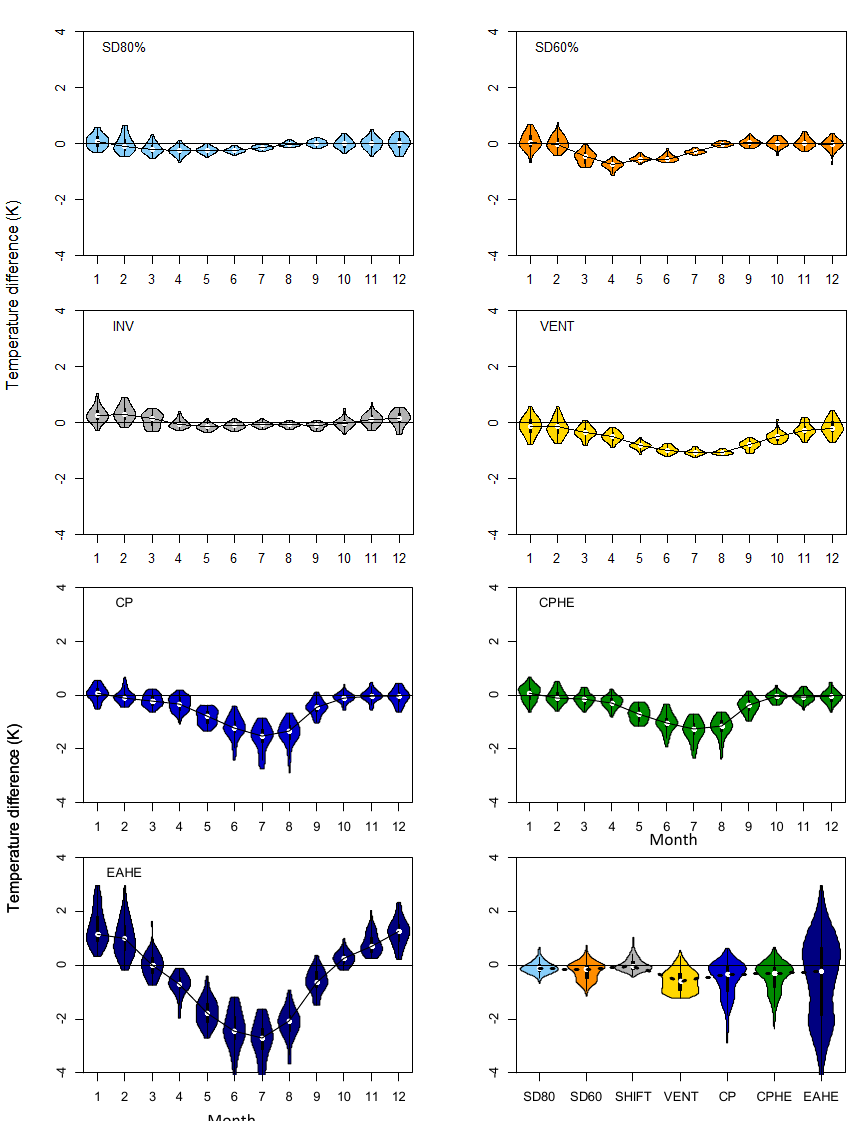
Figure 2. Violin plot of the difference of the monthly mean values (period 1981–2017) of the indoor temperature for a specific AM relative to the reference building REF. Adaptation measures: stocking density SD80%; stocking density SD60%; inversion of the resting and activity periods INV; doubling the ventilation rate VENT; cooling pads CP; cooling pads and heat exchanger CPHE; and earth-air heat exchanger EAHE. The annual mean values of the temperature differences (black dashed line), as well as their intra-annual spread, are shown in the lowest right graph. In Figure 3, the difference of the ventilation rate per animal place between the refer- ence building REF and the application of the AMs is shown. During summertime, the slight reduction of the heat release of the animals by SD80% and SD60% also causes a